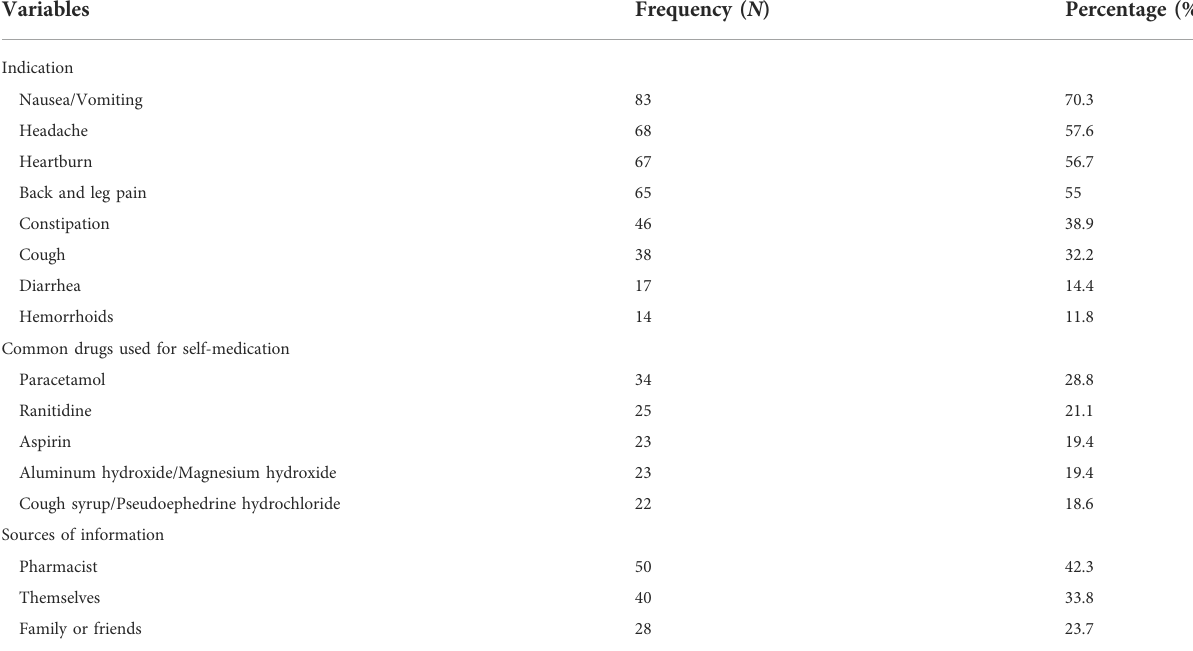
TABLE 2 Characteristics of modern drug self-medication among pregnant women at Settat, 2019 ( n =